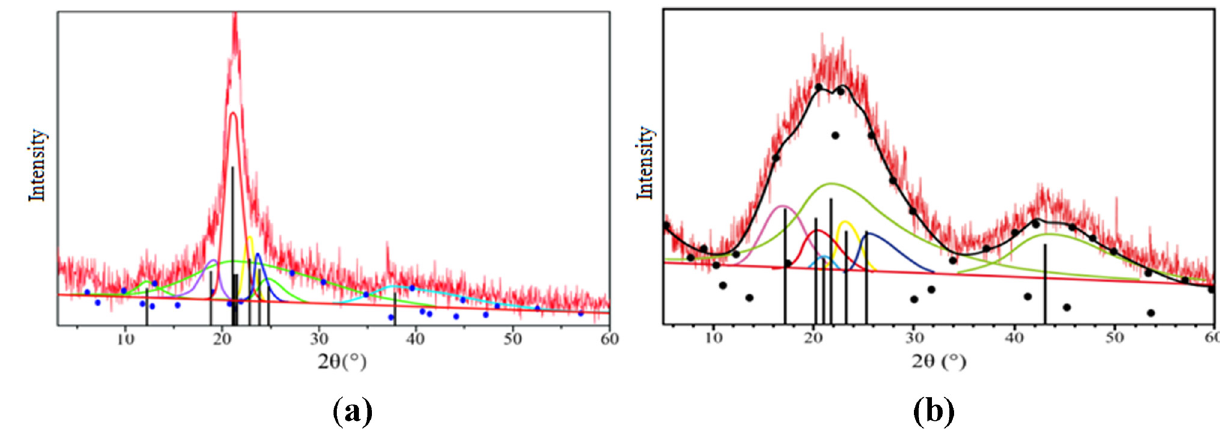
Figure 8: XRD patterns of ( a ) pure bio - based PA56 and ( b )